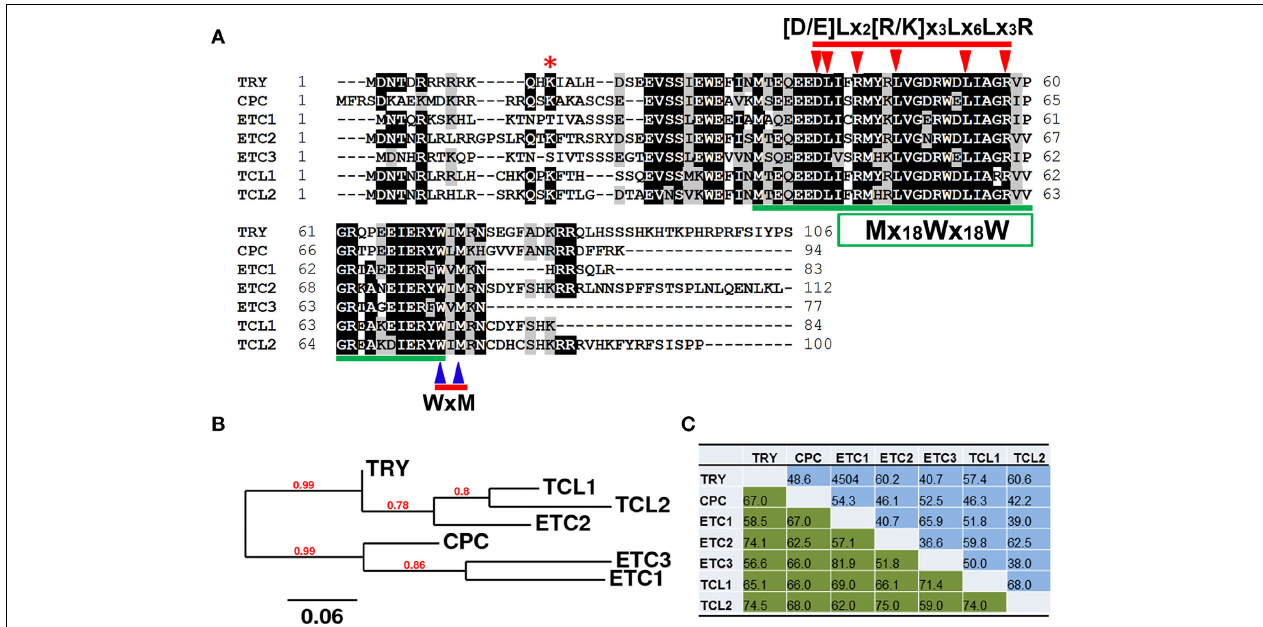
FIGURE 1 | Single-repeat R3 MYB transcription factors in Arabidopsis thaliana . (A) Amino acid sequence alignment of R3 MYBs. Identical and similar amino acids are shaded in black and gray, respectively. The amino acids of [D/E]Lx 2 [R/K]x 3 Lx 6 Lx 3 R signature that is required for interaction between MYBs and R/B-like bHLH transcription factors are indicated by arrowheads on the top of amino acids. The amino acids of WxM signature that is crucial for cell-to-cell movement are indicated by